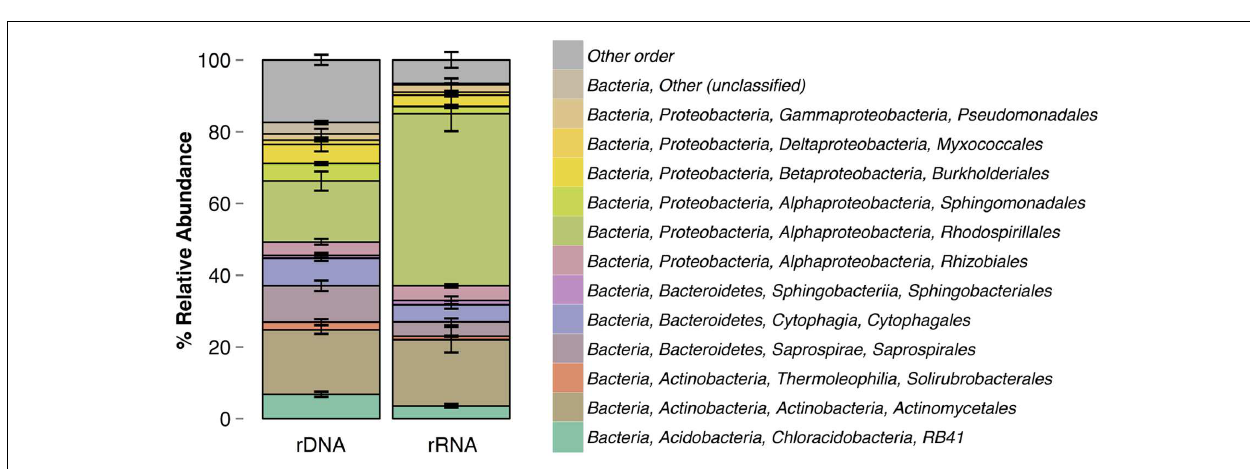
FIGURE 2 | Order-level taxonomic composition of rRNA and rDNA communities. Errors bars are standard